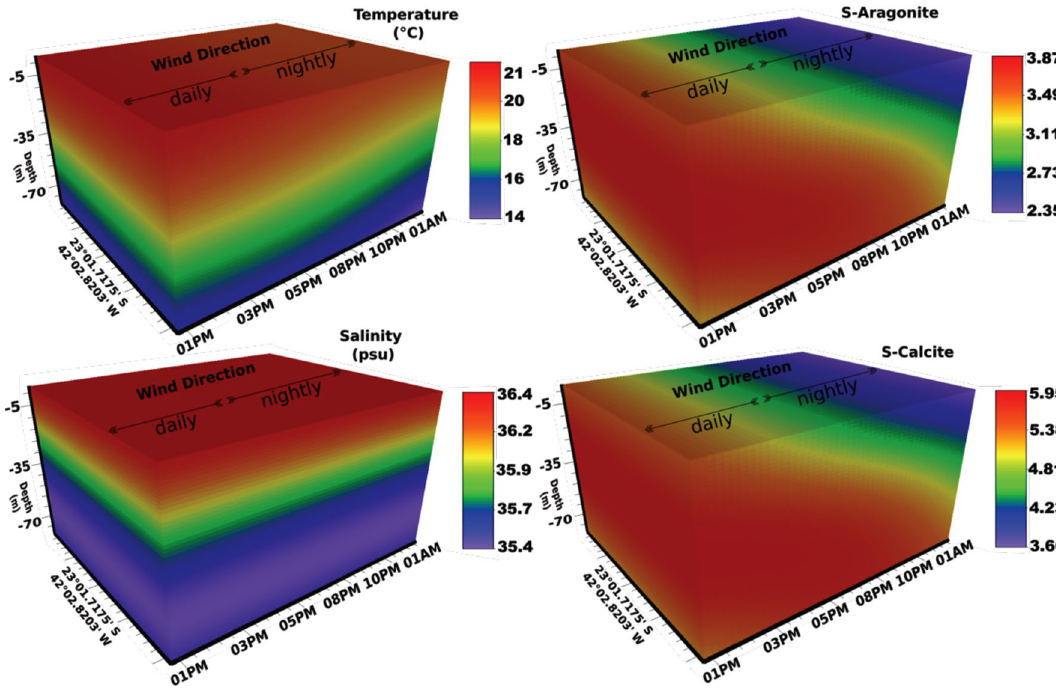
Figure 10. Temporal sampling. Temperature (°C), salinity (psu), aragonite, and calcite saturation state. X-axis: hour–day. Y-axis: coordinates of stations. Z-axis: Depth-m. Data sampled from 1:00 p.m. to 1:00 a.m. on the 20th and 21st of January